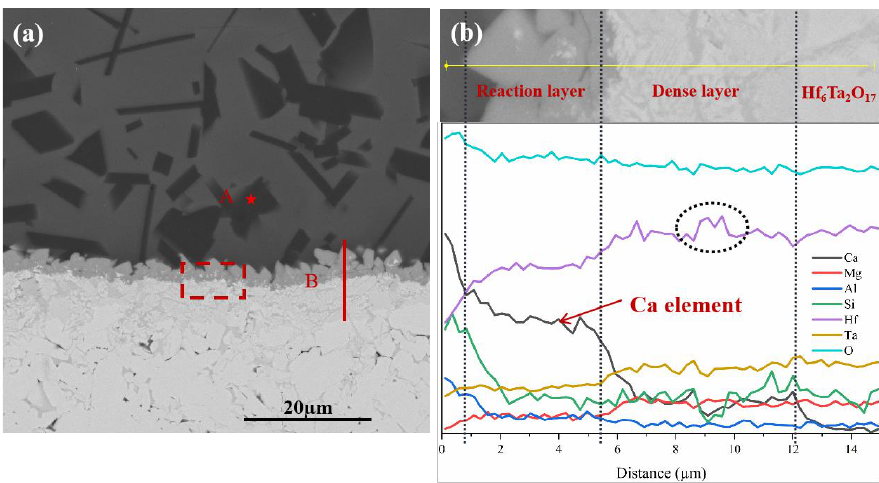
Figure 8. ( a ) Cross-sectional BSE images of Hf 6 Ta 2 O 17 after CMAS attack at 1250 °C for 16 h; ( b ) EDS line scan in location B of ( a ).